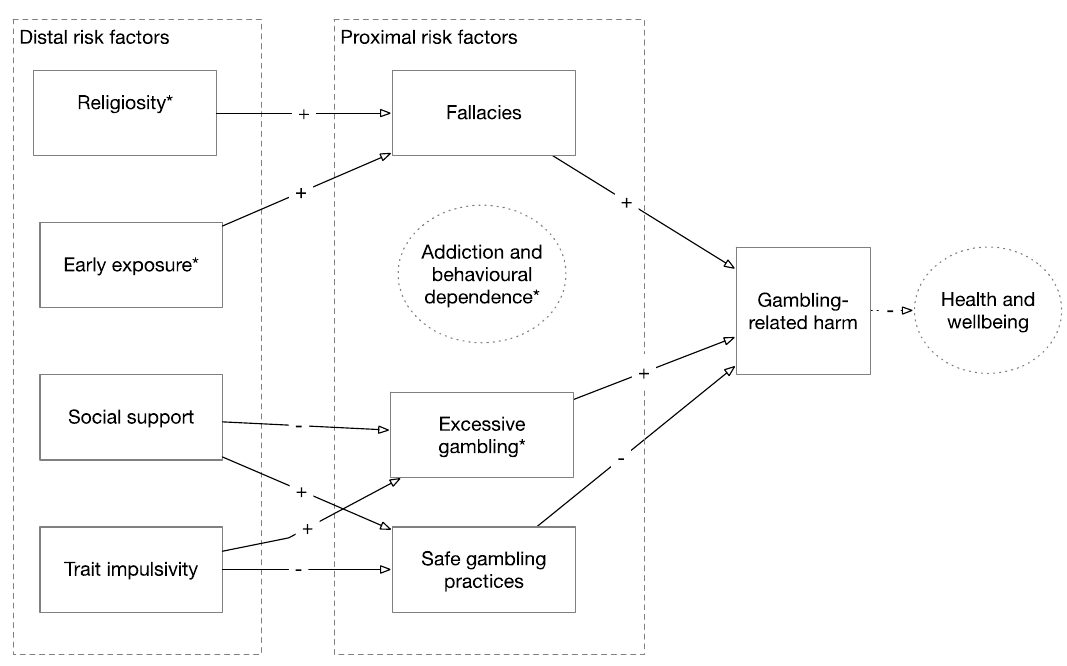
Figure 2. Conceptual diagram summarising relationships between risk factors identified in this study.